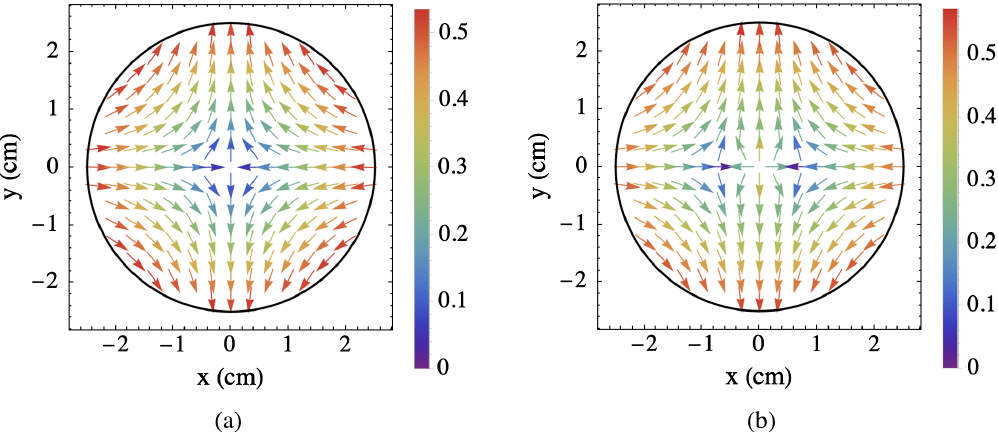
FIG. 12. Vector plots of the transverse electric field (MV/m) in a cross section of the beam pipe without the presence of a beam (a) and a plot of the percent difference in that potential when the proton beam (again scaled by 10) is present (b).